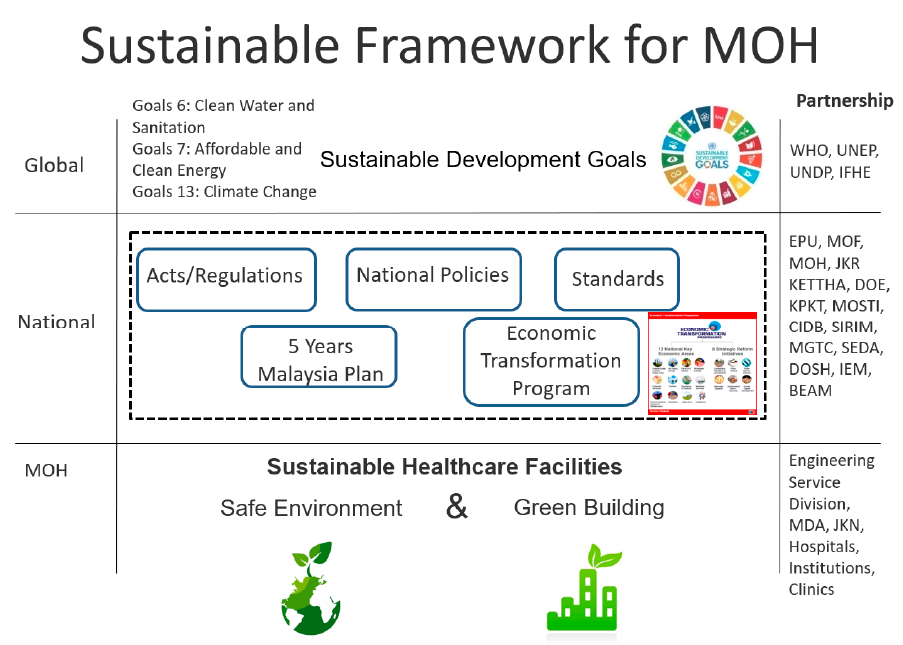
Figure 1. Sustainable framework for government hospital